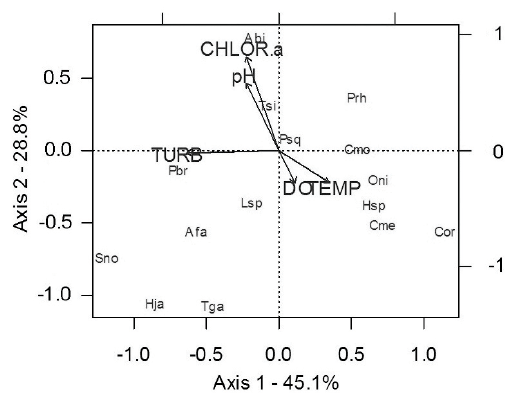
Figure 4. CCA ordination with fish species and limno-